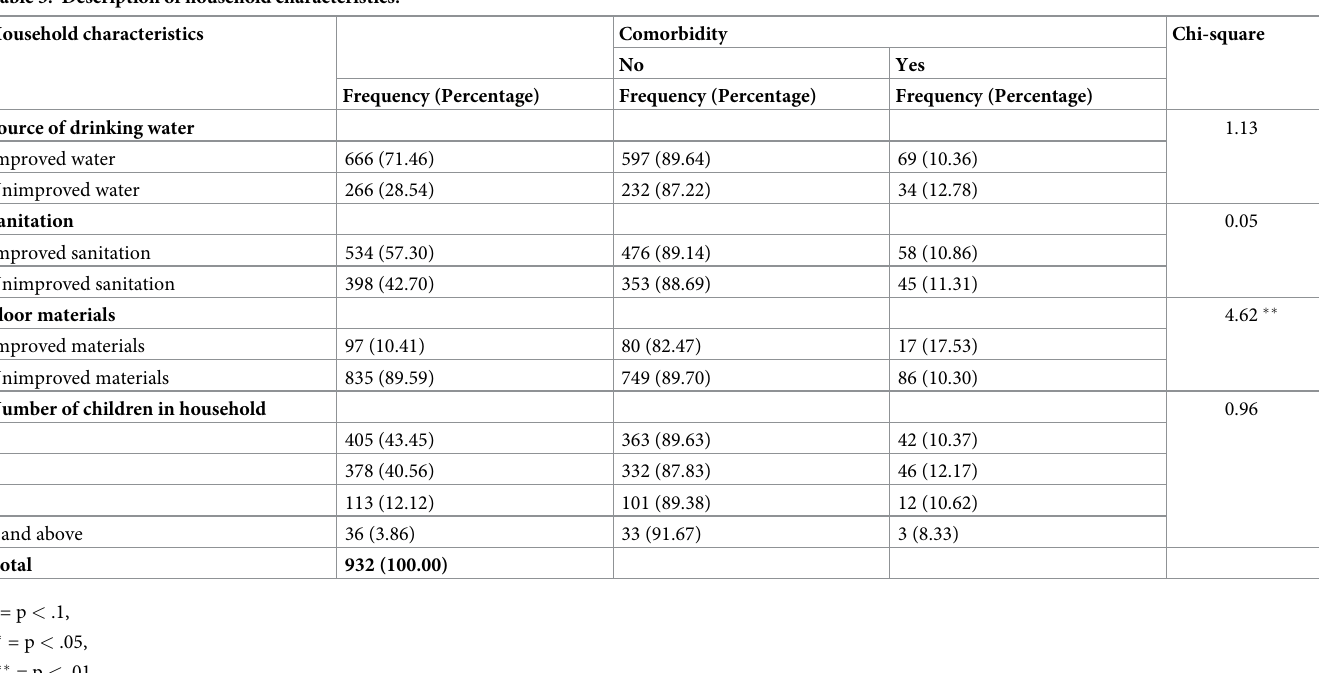
Table 3. Description of household